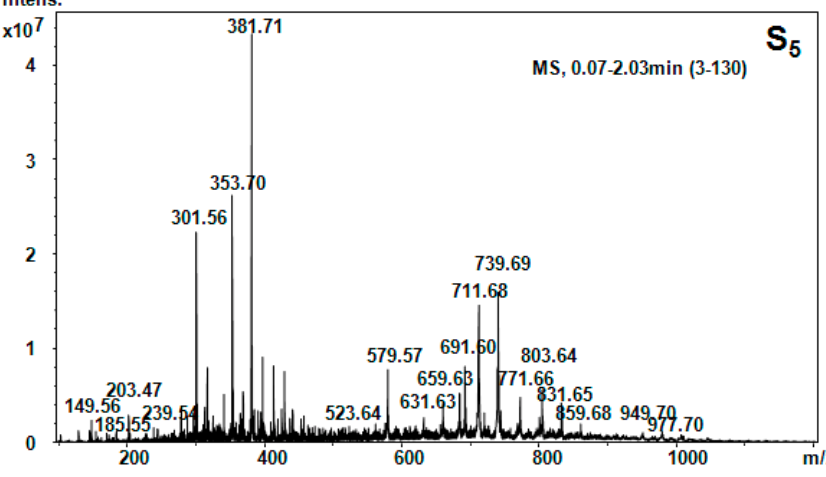
Figure 7. Positive ion mode nano-ESI-Chip-MS for S 5 hellebore fraction.